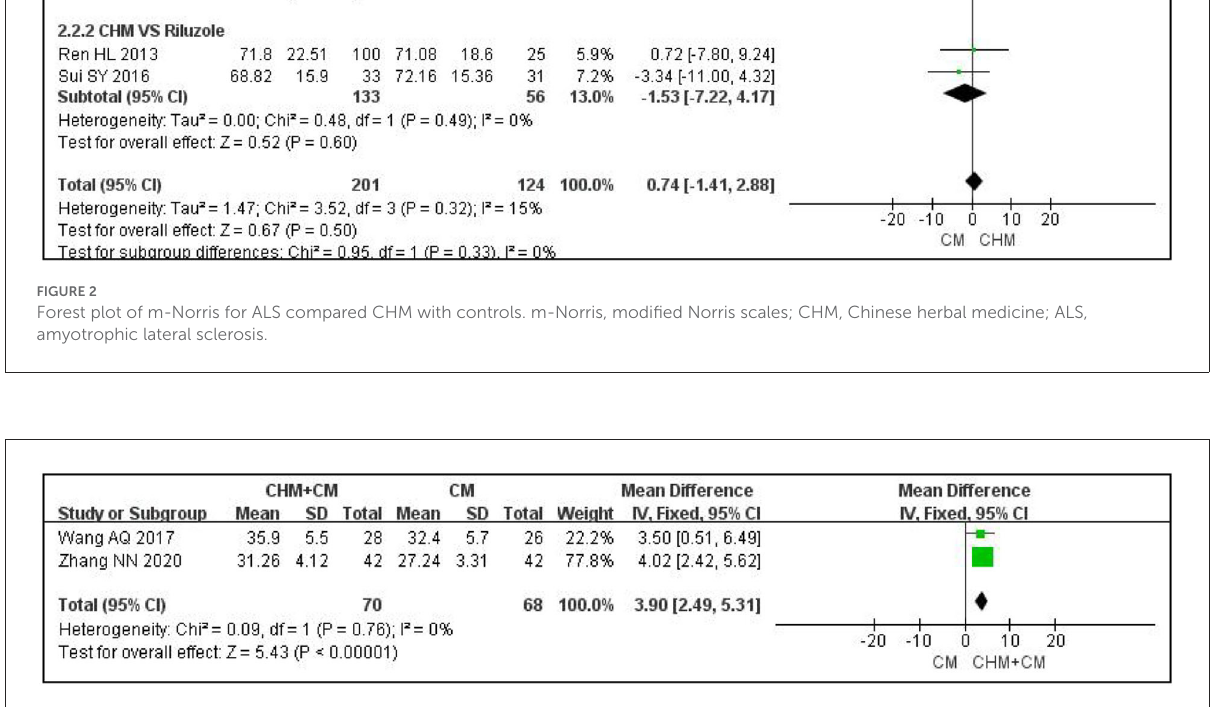
FIGURE3 Forest plot of ALSFRS-r for ALS compared CHM plus CM with CM. r-ALSFRS, revised ALS functional rating scales; CHM, Chinese herbal medicine; ALS, amyotrophic lateral sclerosis; CM, conventional